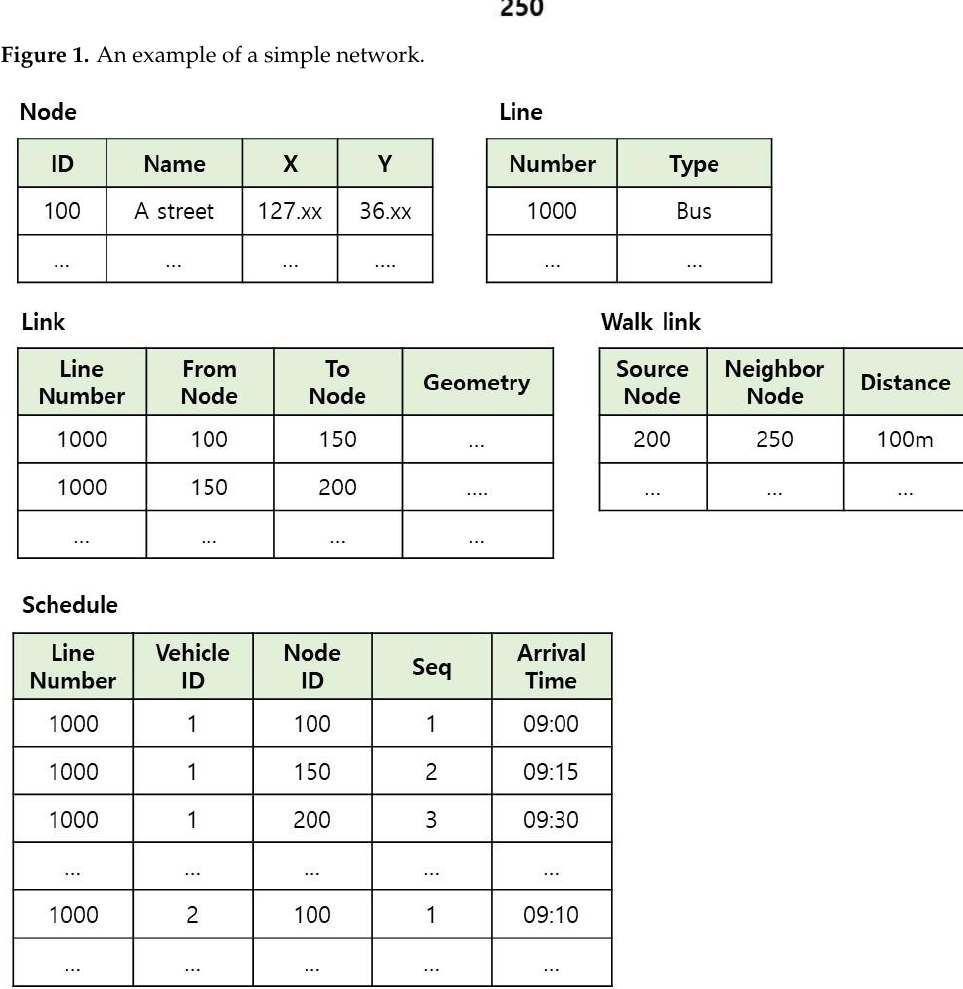
Figure 2. Data tables of a public transport network.